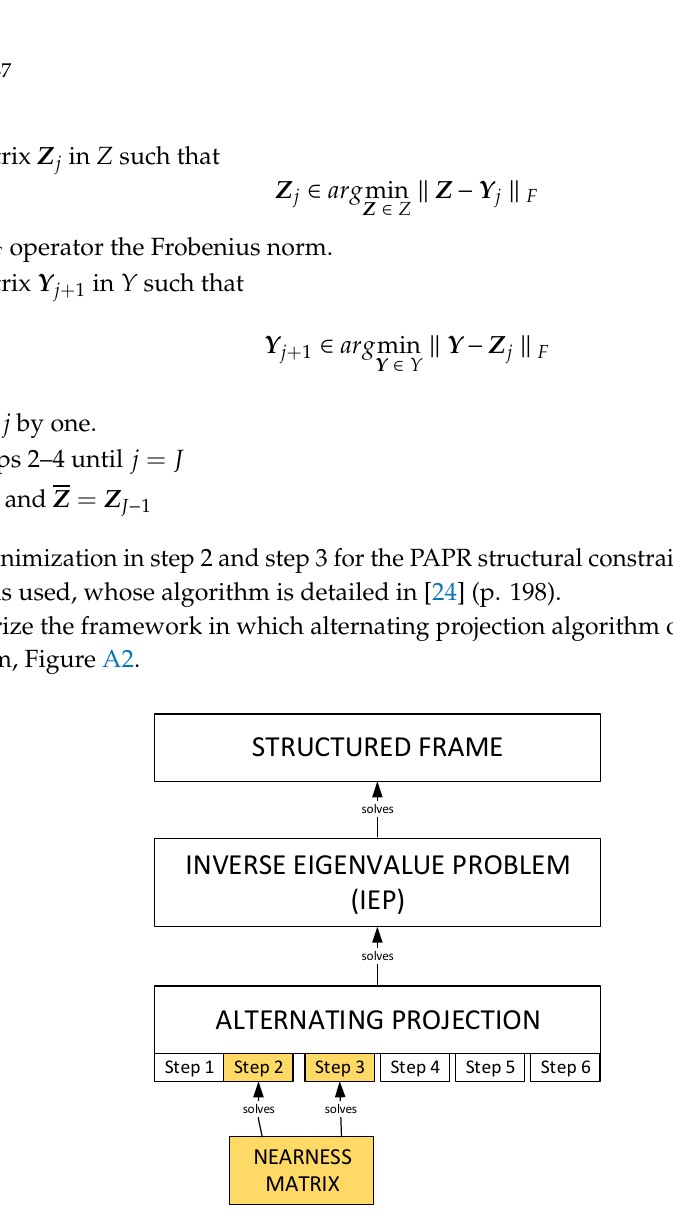
Figure A2. Solution to the Structured Frame problem in turn addressed by Alternating Projection and Nearness Matrix problem.